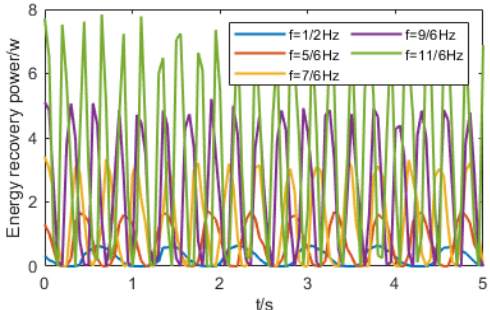
Figure 9. Instantaneous energy recovery power at different frequencies. Table 1. Energy recovery test data.